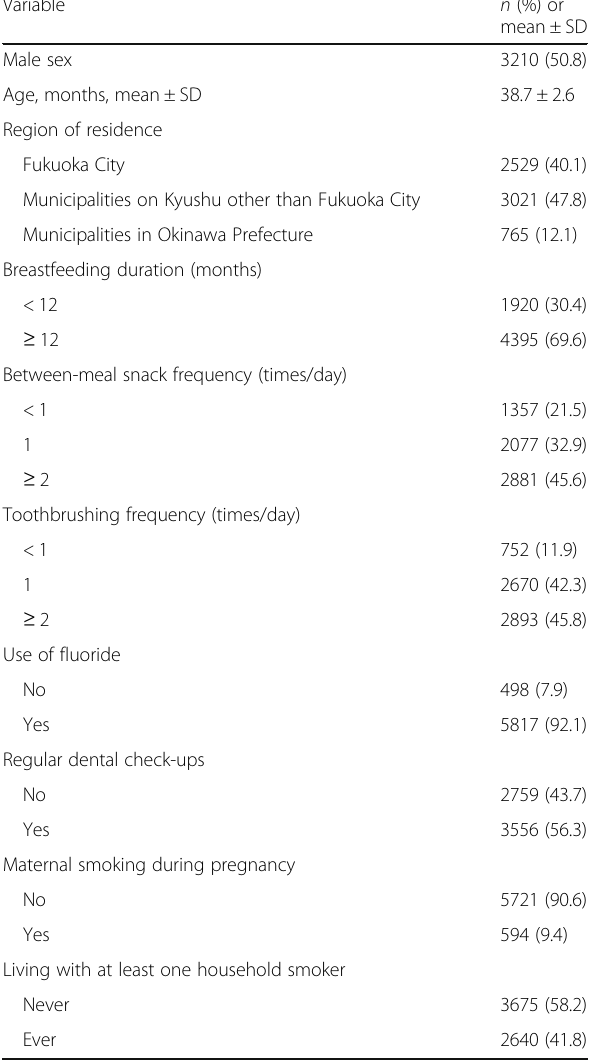
Table 1 Distribution of selected characteristics in 6315